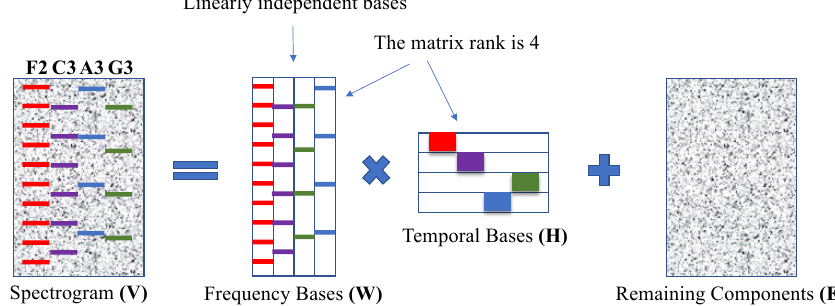
Figure 5. Illustrative diagram for the NMF model and matrix rank ( R =